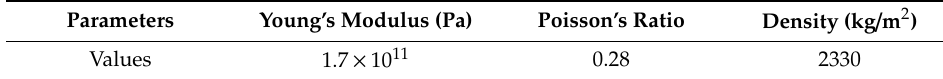
Table 2. Material parameters for FEM simulation.